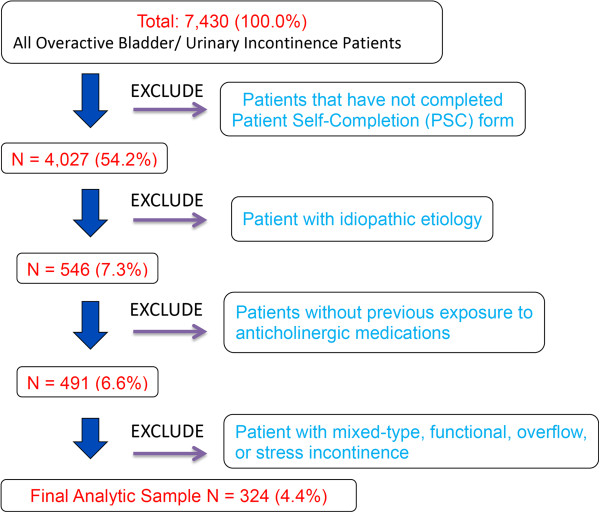
Patient cohort selection flowchart.